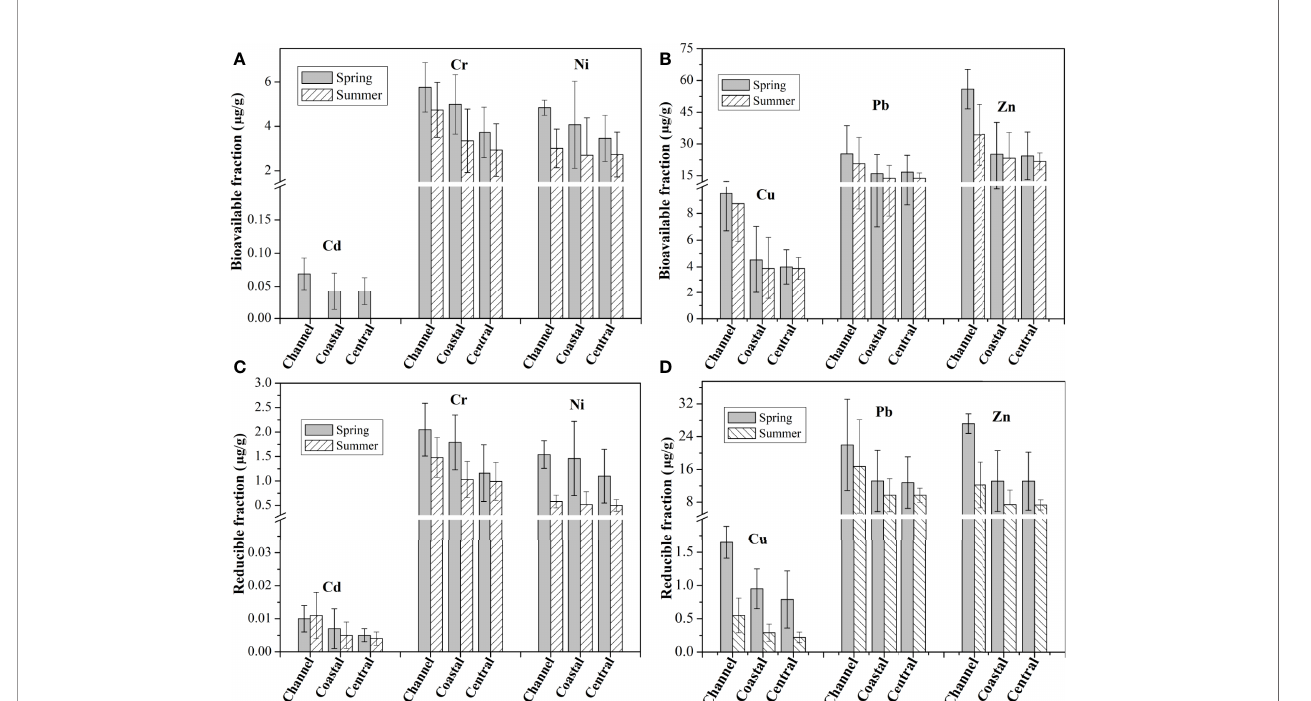
FIGURE 4 | Average concentrations of bioavailable (A, B) and reducible (C, D) fraction of metals in different subregions of Zhanjiang